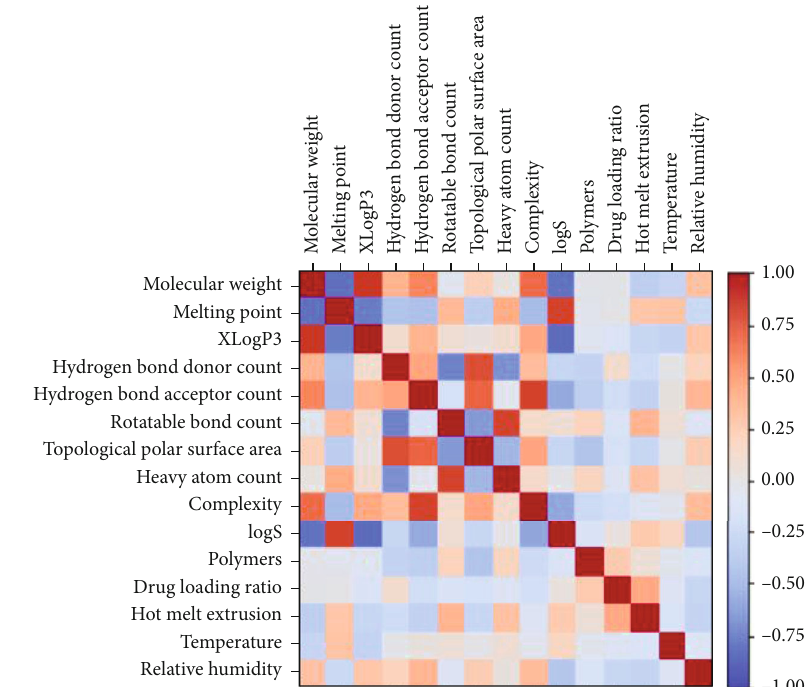
Figure 1: The correlation of the features in the training